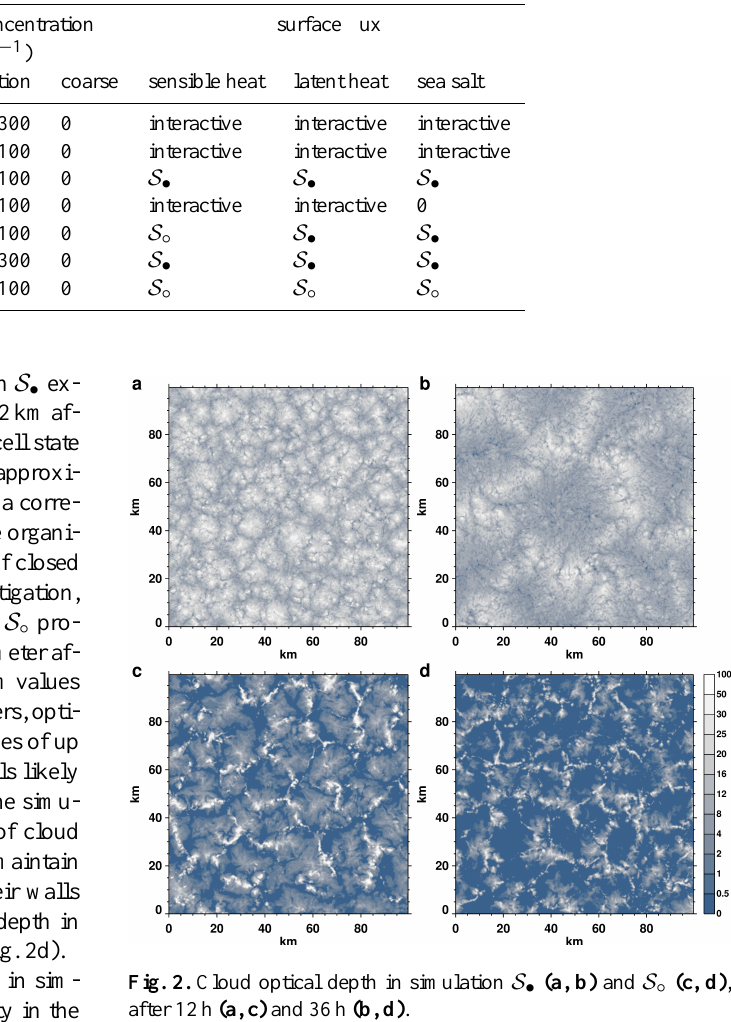
Table 1. List of simulations. Closed and open circles represent the closed- and open-cell character of the simulations. The setup of the simulations is identical in all aspects other than those listed here. In simulations with prescribed surface fluxes, the fluxes are spatially homogenized. Simulation initial aerosol concentration